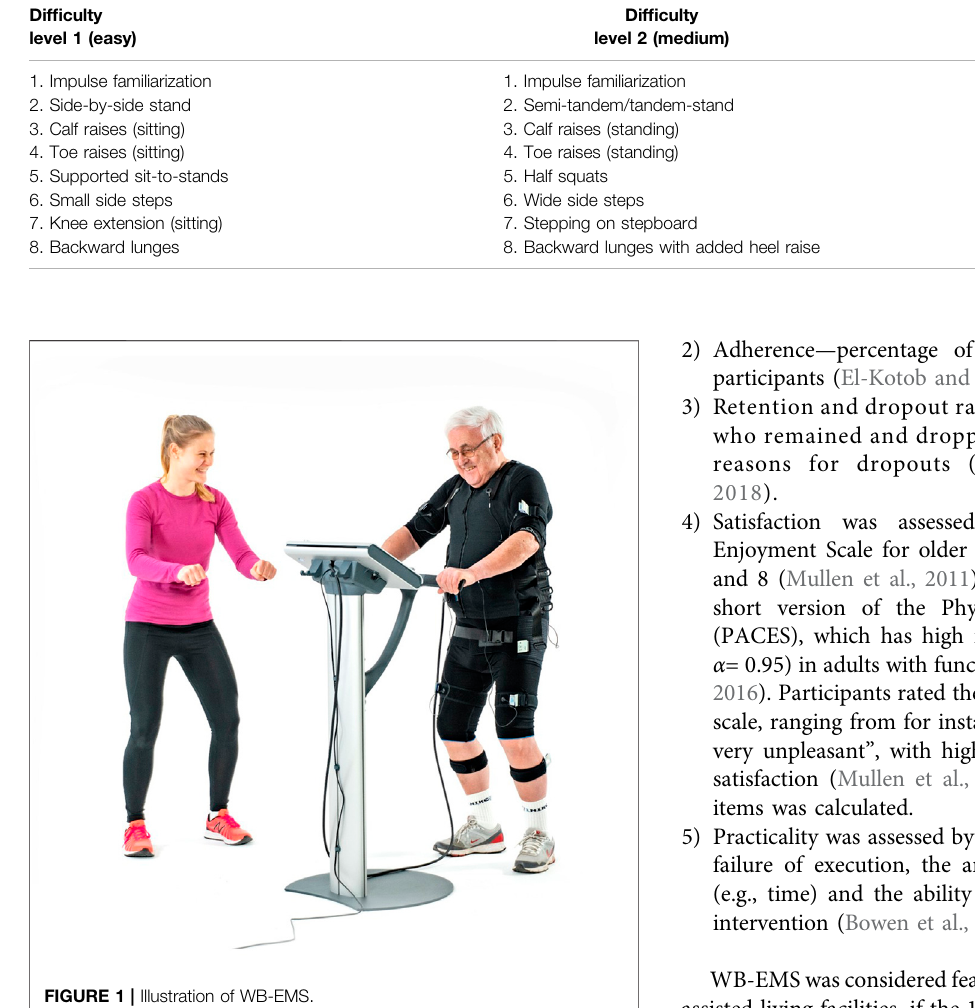
FIGURE 1 | Illustration of